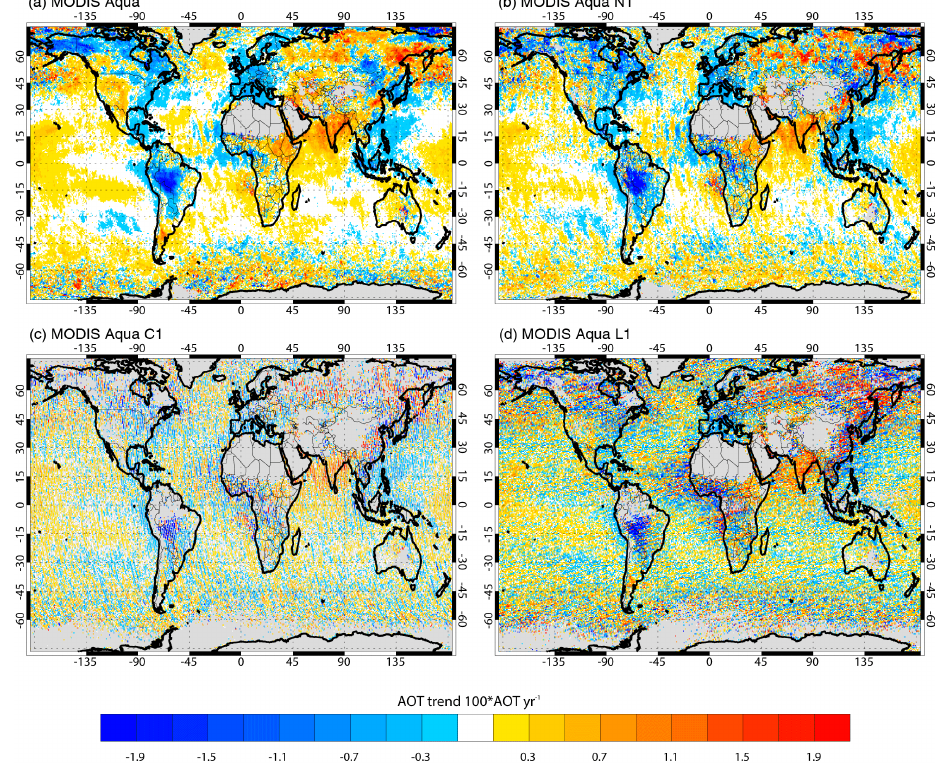
Figure 11. Trend for the 10-year (2003–2012) time series of MODIS Aqua AOT. We show the trend for the (a) full swath, (b) N1, (c) C1, and (d) L1 samplings. Grey areas are locations with either no valid retrievals or where the time series has fewer than 12 month n and month n − 1